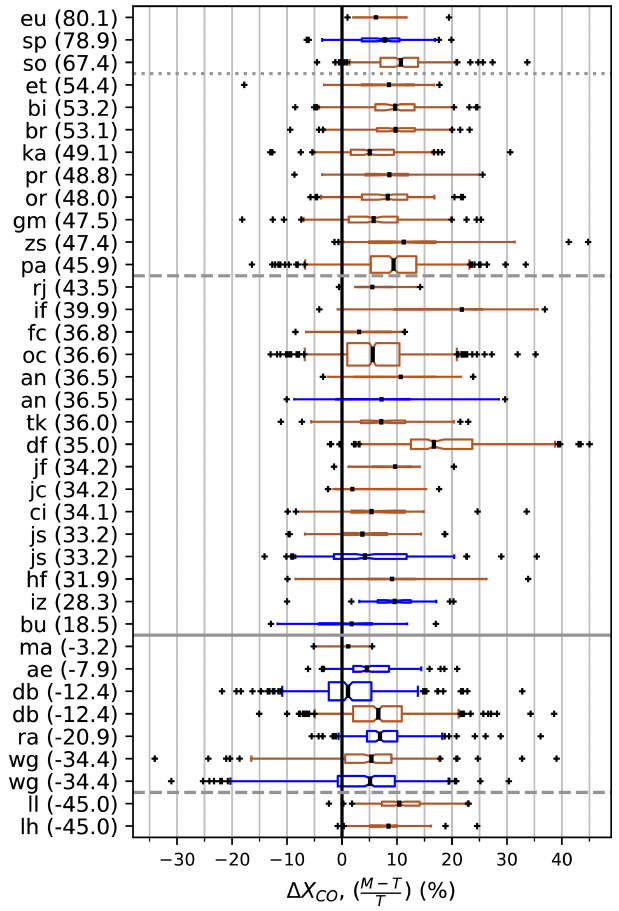
Figure 6. Boxplots of the MOPITT–TCCON percent difference at the TCCON sites (using method II), ordered by latitude (degrees north in parenthesis). Blue boxes are MOPITT soundings over wa- ter, and brown boxes are those over land. Whiskers represent the inner 95% of data. Notches are 95% confidence intervals of the median. Box heights represent the relative number of observations. The solid horizontal line is the Equator, dashed lines are ± 45 ◦ , and the dotted line is 60 ◦